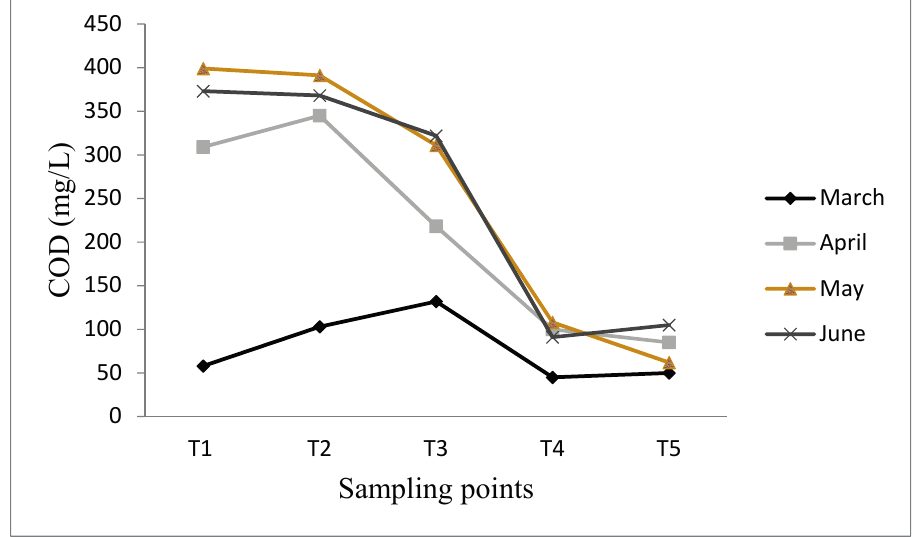
Figure 3. COD concentrations in different sampling points in Thohoyandou